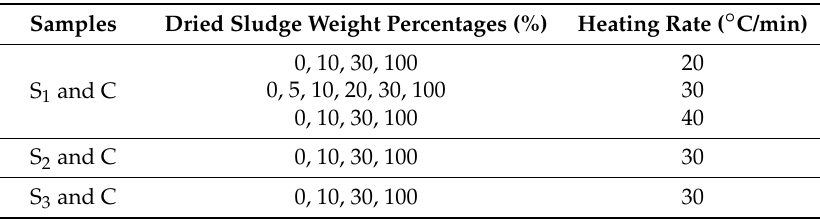
Table 2. Test conditions